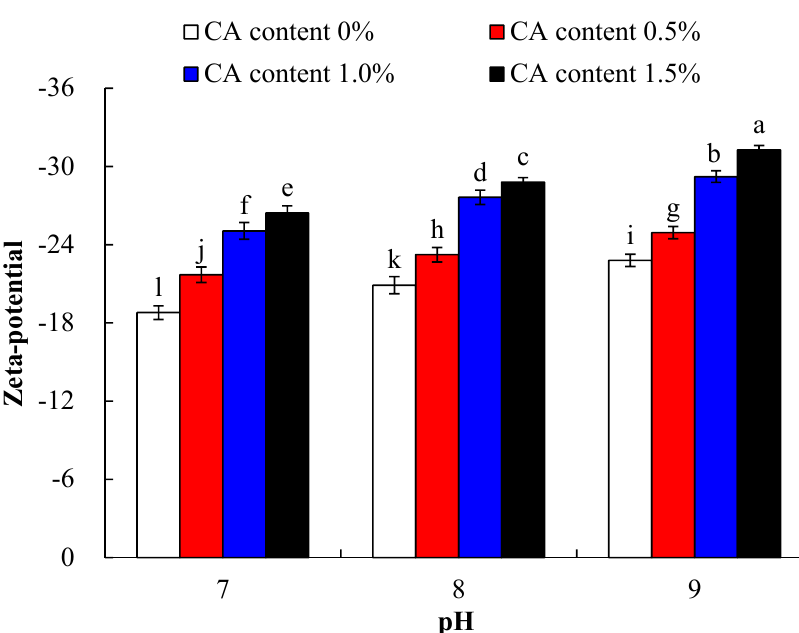
Figure 1. Surface hydrophobicity of WPI incubated with CA (0, 0.5, 1.0 and 1.5%) at pH 7.0, pH 8.0, or pH 9.0, at 50 °C for 6 h. Error bars represent the standard deviation of the mean of triplicate experiments. Values with different letters are significantly different ( p < 0.05).